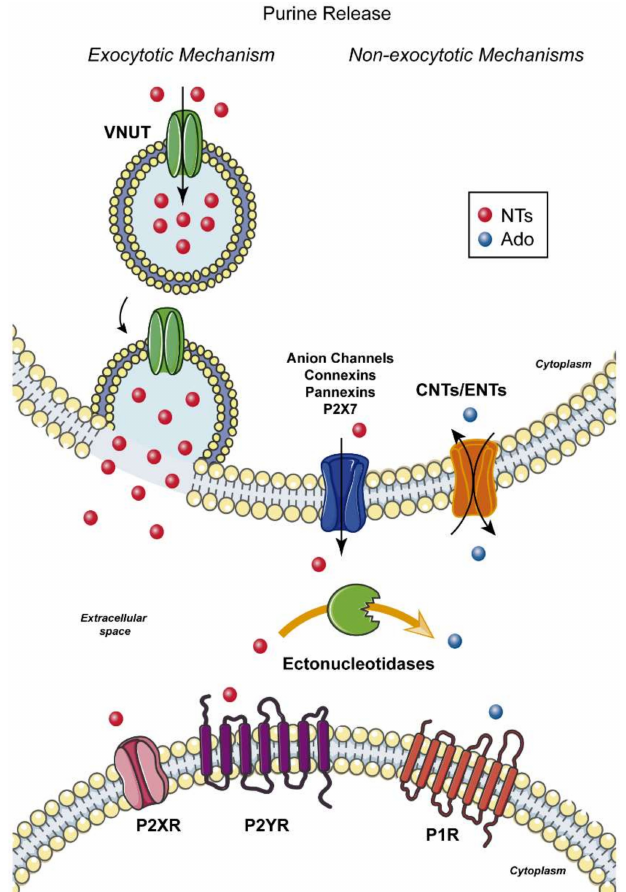
Figure 1. Purine release mechanisms: purines such as ATP and adenosine can be actively released from neurons and glial cells including microglia and astrocytes or passively from damaged or dying cells. Schematic showing the di ff erent release mechanisms including exocytotic and non-exocytotic mechanisms. Exocytoticmechanismsrequirepreviousstorageofnucleotidesviathevesicularnucleotide transporter (VNUT) in secretory / synaptic vesicles. Non-exocytotic mechanisms include the release of nucleotides by di ff erent types of channels, such as anion channels, pannexins and connexins. In contrast to ATP, adenosine can also be released into the extracellular space via Concentrative Nucleoside Transporters (CNTs) and Equilibrative Nucleoside Transporters (ENTS). Released nucleotides activate P2X and P2Y receptors localized on neuronal or glial membranes. Simultaneously, the hydrolysis of nucleotides by ectonucleotidases produces adenosine which, in turn, activates P1 receptors. Abbreviations: NTs, nucleotides; Ado, adenosine; VNUT, vesicular nucleotide transporter; CNTs, Concentrative Nucleoside Transporters; ENTs, Equilibrative Nucleoside